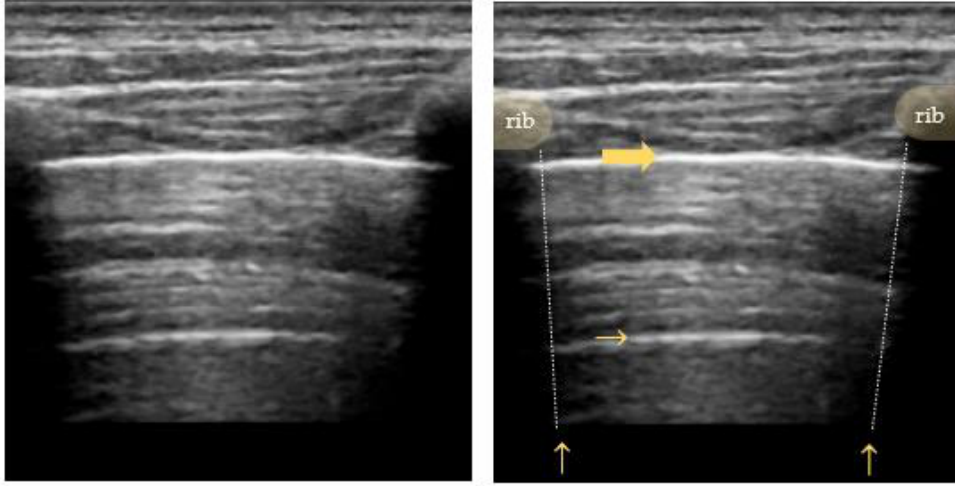
Figure 2. Bat sign: ribs and their sonographic shadow are outlined; the fat arrow points to the pleural line; the small horizontal arrow points to the A-line (reverberation artifact of the pleural line); the vertical arrow points to a rib’s shadow line.